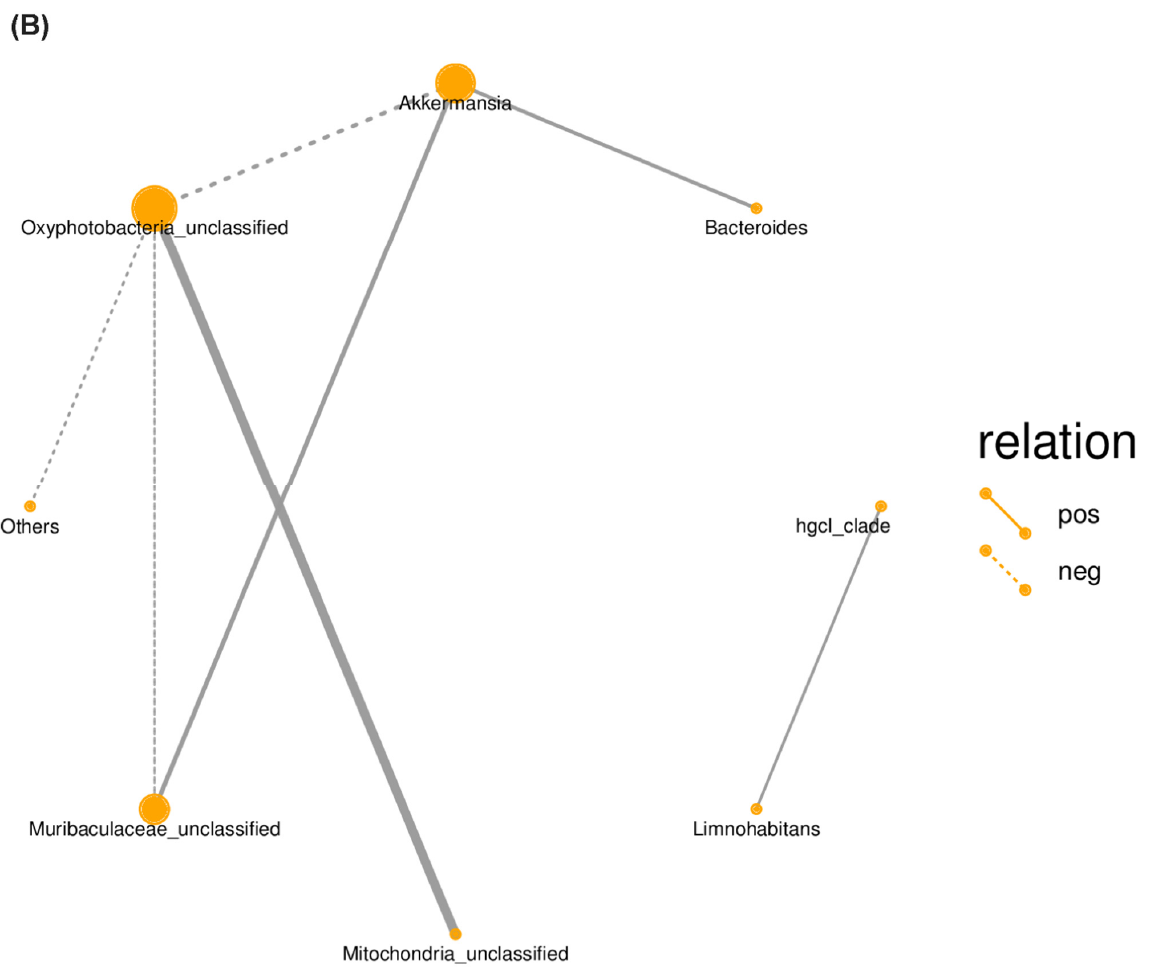
Figure 8. Sparse correlations for compositional data (SparCC). ( A ) correlation heatmap between different bacterial communities; ( B ) correlation network among bacterial communities. A solid line between two bacterial communities indicates a positive correlation, and a dotted line indicates a negative correlation between them. The thicker the solid line, the higher the value of positive correlation between them. The size of the nodes indicates the abundance of bacterial communities. The lower the abundance, the smaller the node.